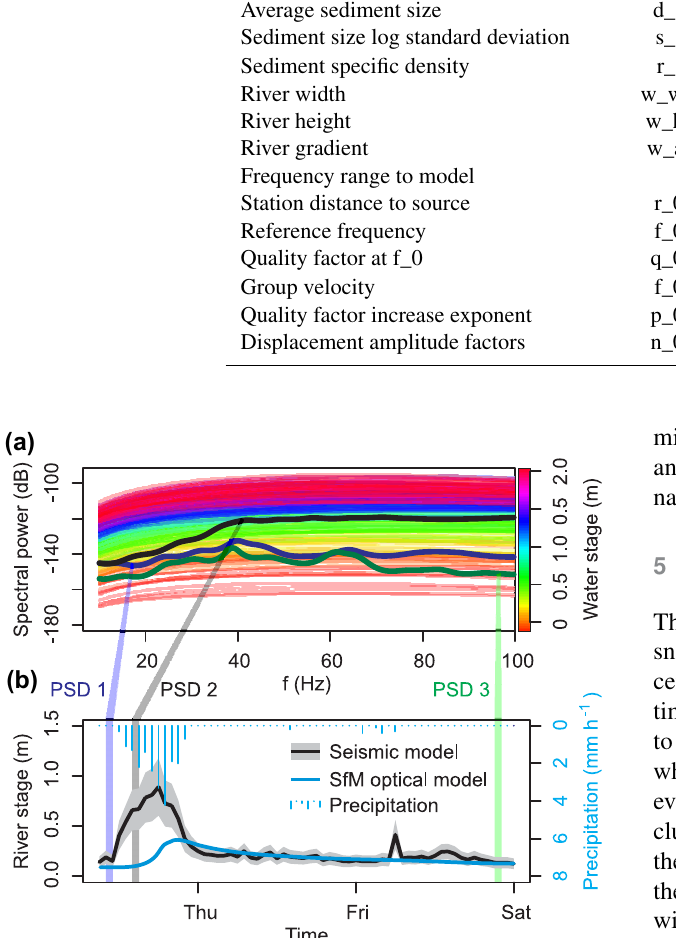
Figure 8. Results of the turbulence modelling exercise. (a) Monte- Carlo-based estimates of spectral power for different water stages at the Wernersbach site together with representative empirical spectra (see panel (b) for timing of the representative spectra). (b) Seis- mically estimated water levels including parameter-inherent uncer- tainty ranges (grey polygon and line) together with independent structure-from-motion-based water levels and precipitation data from a meteorological station about 6km away. Note contamina- tion of the seismic signal of fluvial turbulence by precipitation on Thursday and peak in seismic power due to station maintenance on Friday